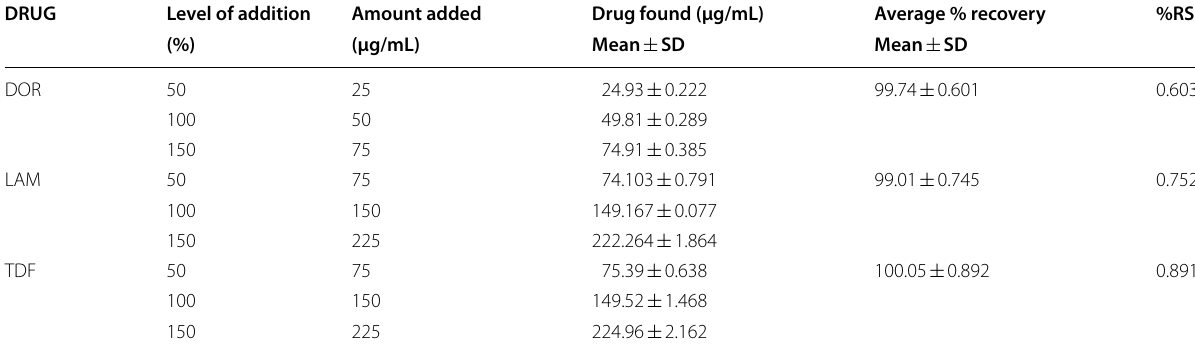
Table 5 Percentage recovery results of DOR, LAM and TDF